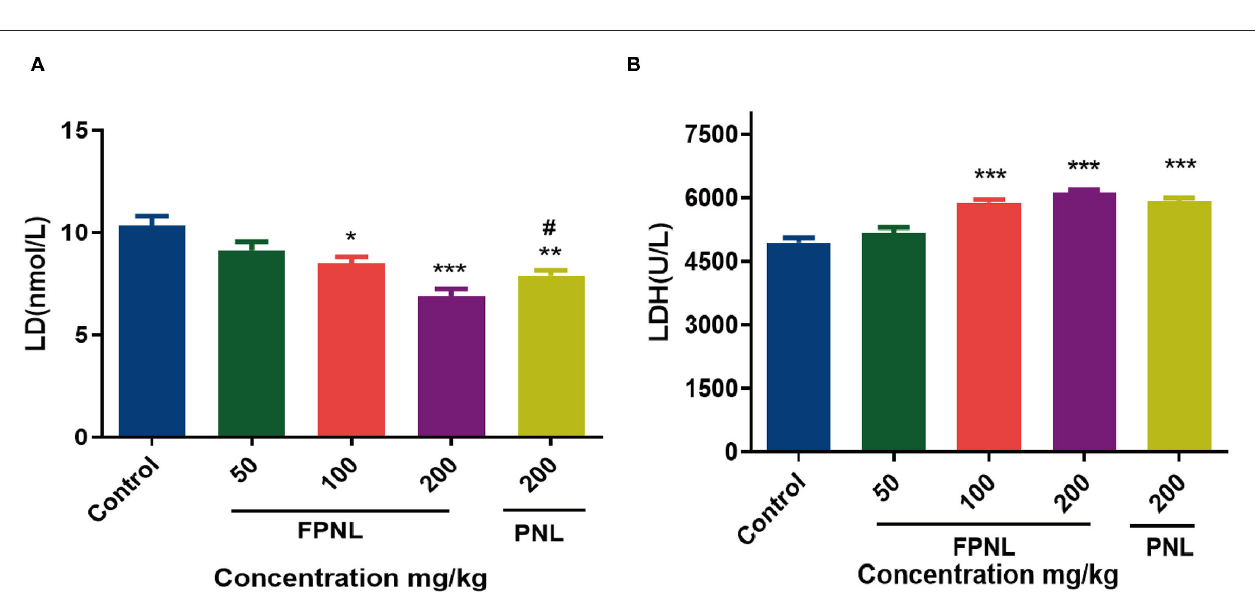
FIGURE 8 | Effect of fermented P. notoginseng leaves and P. notoginseng leaves on LD, LDH level in serum. (A) The LD level in mice serum after swimming. (B) The LDH level in mice serum after swimming. Data are expressed as mean ± SEM from six independent experiments ( n = 6). * P < 0.05, ** P < 0.01, *** P < 0.001 vs. control. # P < 0.05 vs. FPNL (200 mg/kg)